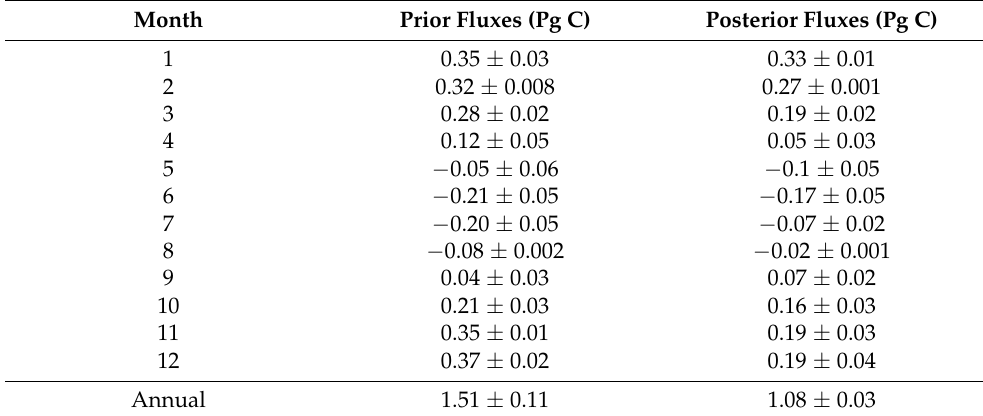
Table 2. Prior and posterior monthly mean CO 2 fluxes of the DA_FLUX experiment over the contiguous United States in